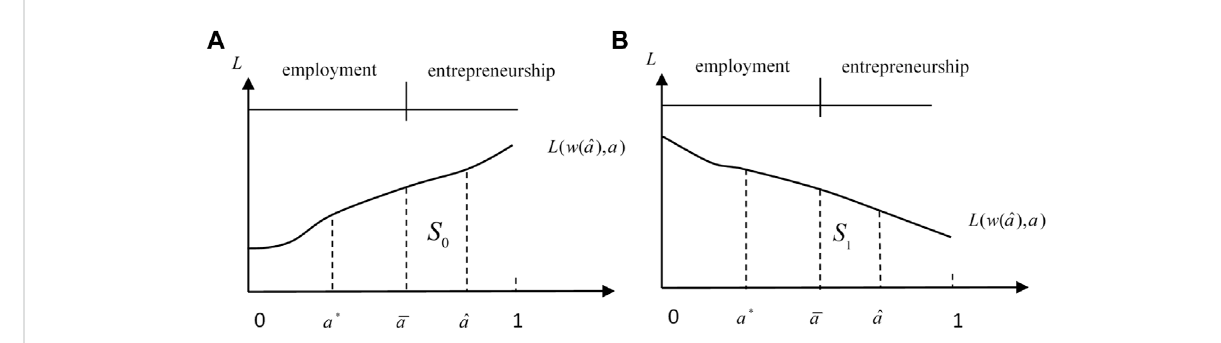
FIGURE 2 The refugee effect and the Schumpeter effect under social capital for